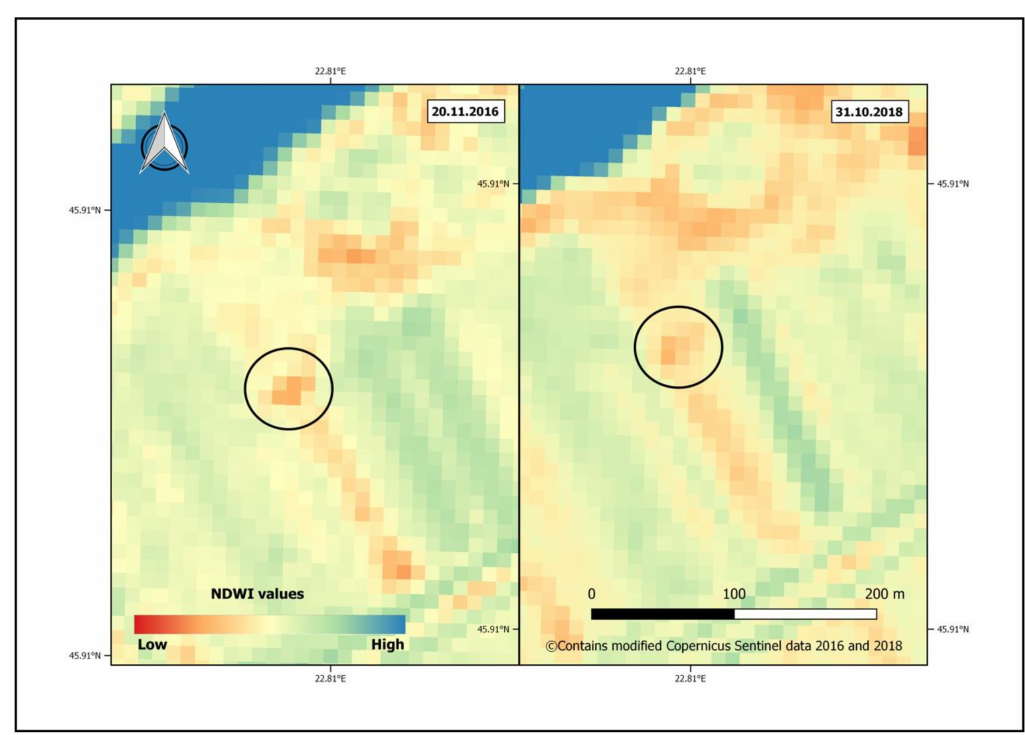
Figure 19. NDWI image output derived from Sentinel–2 imagery. The highlighted features represent the north–east wall of the Micia Fort. Based on the analysis of the NDWI, the di ff erences in soil moisture indicate the presence of underground structures.